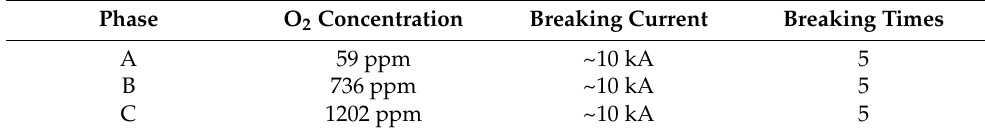
Table 2. Setting of breaking experiment with different O 2 concentration.